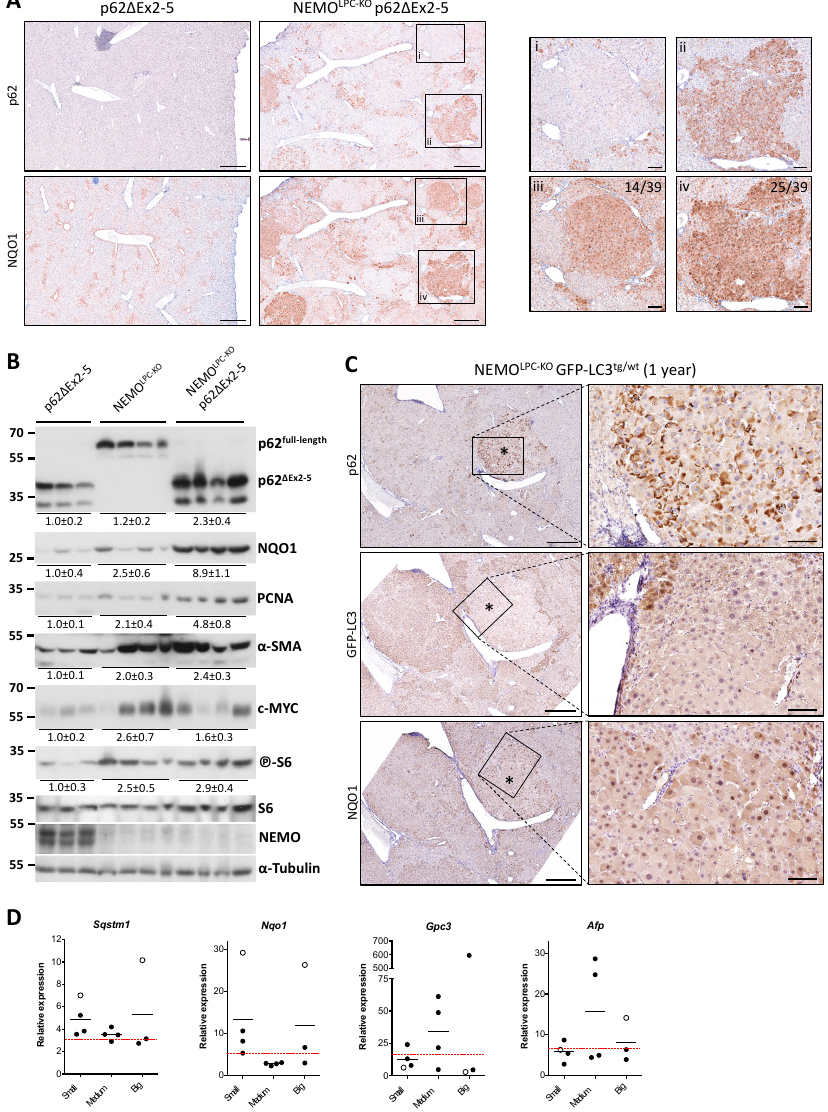
Figure 7. Frequent activation of the p62-Keap1-Nrf2 axis in liver tumors of NEMO LPC-KO mice correlates with an underlying autophagy impairment and low Gpc3 expression. ( A ) Representative images of immunostaining for p62 ∆ Ex2-5 and NQO1 performed by IHC on sequential liver sections from 1-year-old p62 Δ Ex2-5 or NEMO LPC-KO p62 Δ Ex2-5 mice. Insets illustrate examples of p62 neg Nrf2 pos (i and iii) and p62 pos Nrf2 pos (ii and iv) tumors. The frequency of the two types of Nrf2 pos tumors is presented ( n = 39). ( B ) Immunoblot analysis of the indicated proteins in total liver lysates from 1-year-old mice with the indicated genotypes. α -Tubulin is used as the loading control. Band quantification represents the mean intensity ± SEM per genotype relative to control mice (p62 Δ Ex2- 5) and normalized to α -tubulin. Uncropped scans of the immunoblots are shown in Figure S5. ( C ) Representative images of immunostaining for p62, GFP-LC3 and NQO1 performed by IHC on se- quential liver sections from 1-year-old NEMO LPC-KO GFP-LC3 tg/wt mice. Note that the dysplastic nod- ule (asterisk) with high accumulation of p62 aggregates and increased NQO1 expression is negative